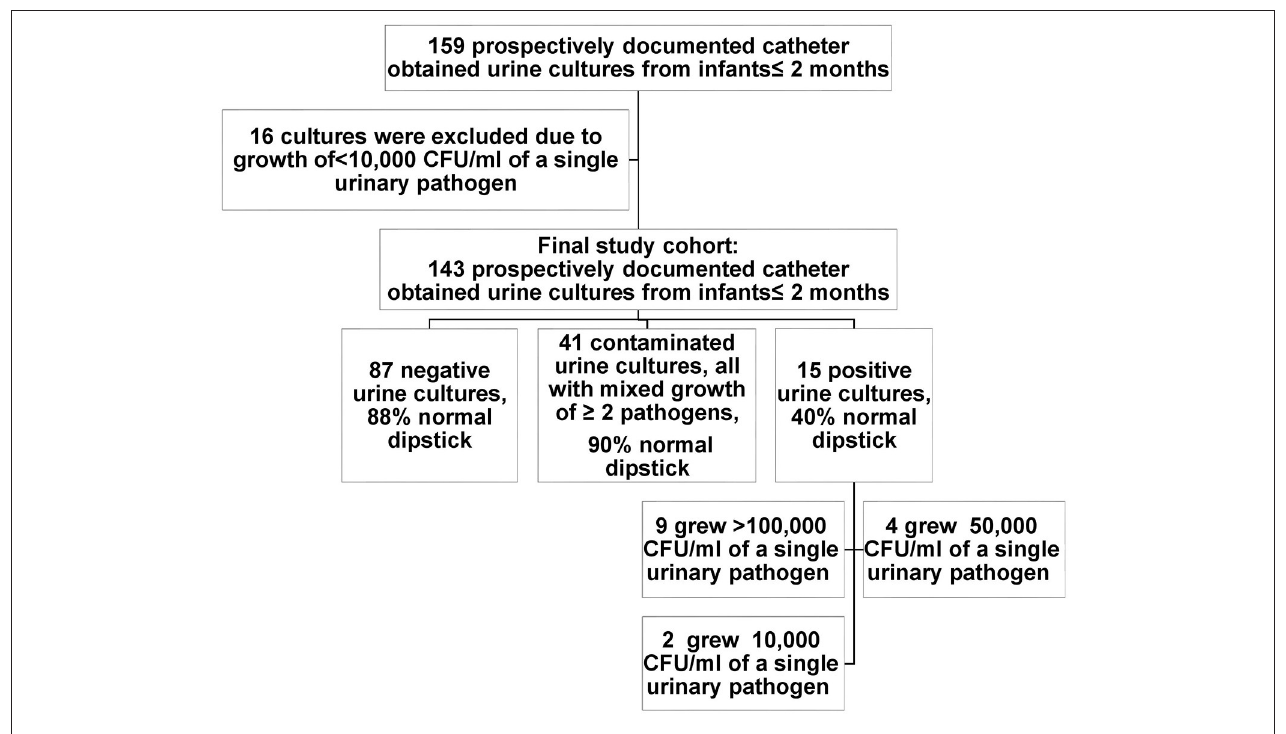
FIGURE 1 | Dipstick and urine culture characteristics of the study cohort.